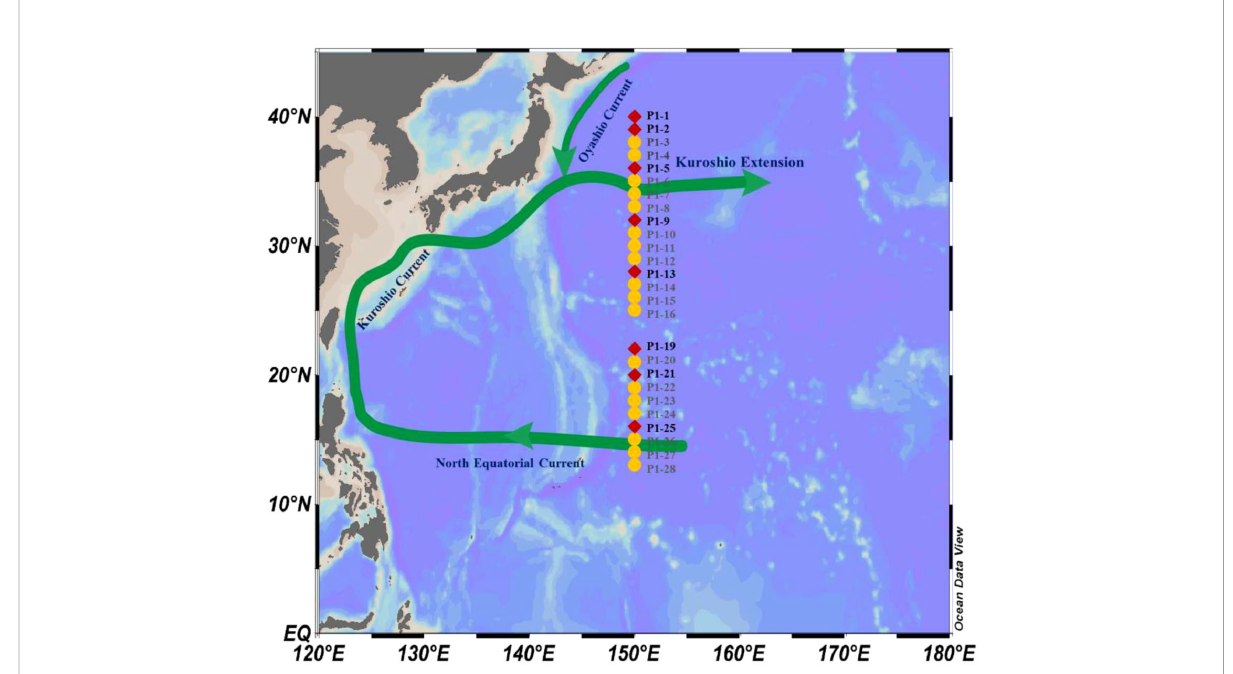
FIGURE 1 Map of the study region plotted using Ocean Data View (ODV, Schlitzer, 2015) and the sampling transect stations of line P1 in the northwestern North Paci fi c in November 2019. Red diamonds are the stations for measuring d 13 C throughout the sampling water